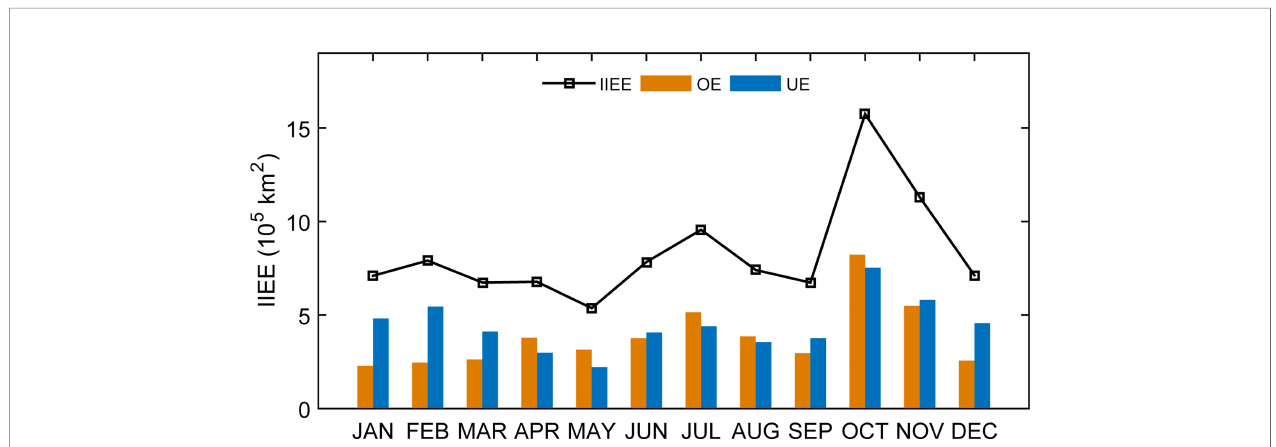
FIGURE 12 | Seasonal cycle of IIEE and its two components, overestimated error (OE) and underestimated error (UE), during the test period 2015 – 2020 from sea ice forecast of